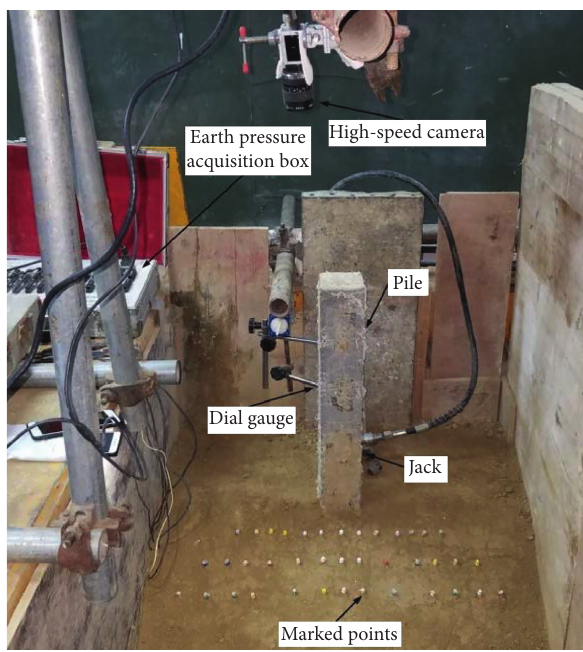
Figure 3: Scene diagram of model test.